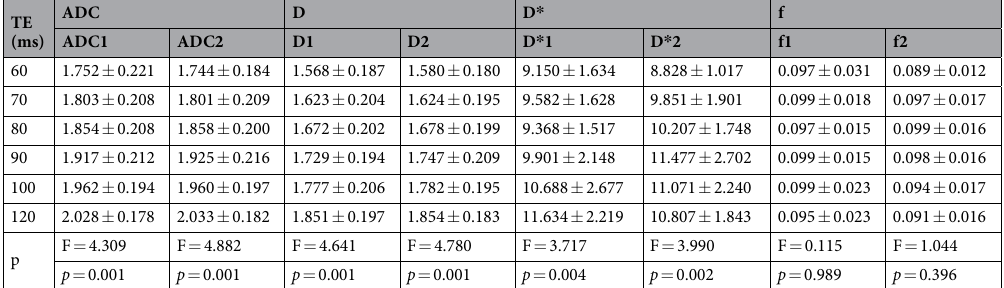
Table 3. ADC, D, D * and f in the peripheral zone with different TE values, and ANOVA results. Note: Data are represented as the means ± standard deviations; ADC, D, D * are in units of 10 − 3 mm 2 /s, f has no units; ADC1, D1, D * 1 and f1 are the measurement results for the first examination; ADC2, D2, D * 2 and f2 are the measurement results for the second examination.